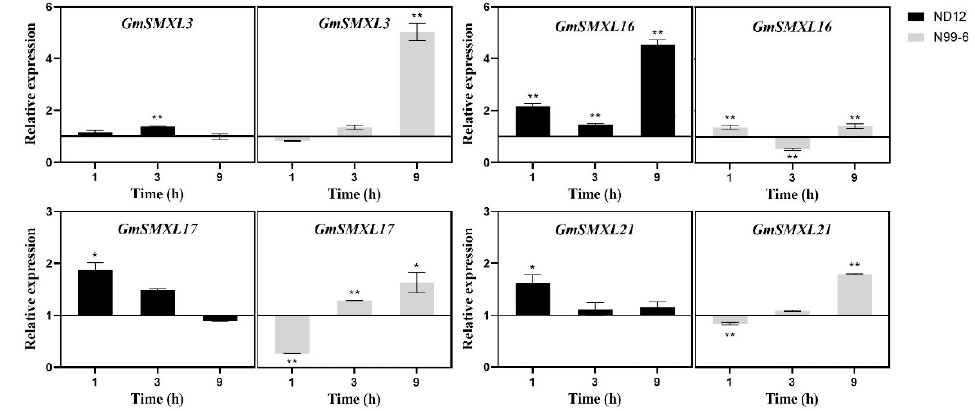
Figure 11. The expression levels of GmSMXL genes in ND12 and N99-6 relative to their normal light treatment after shading treatment. The values referred to the mean ± standard error (SE) of three independent biological replicates. Asterisks manifested the corresponding genes significantly up- or down-regulated compared with those in normal light treatment. (* p < 0.05, ** p < 0.01, Student’s t -test).